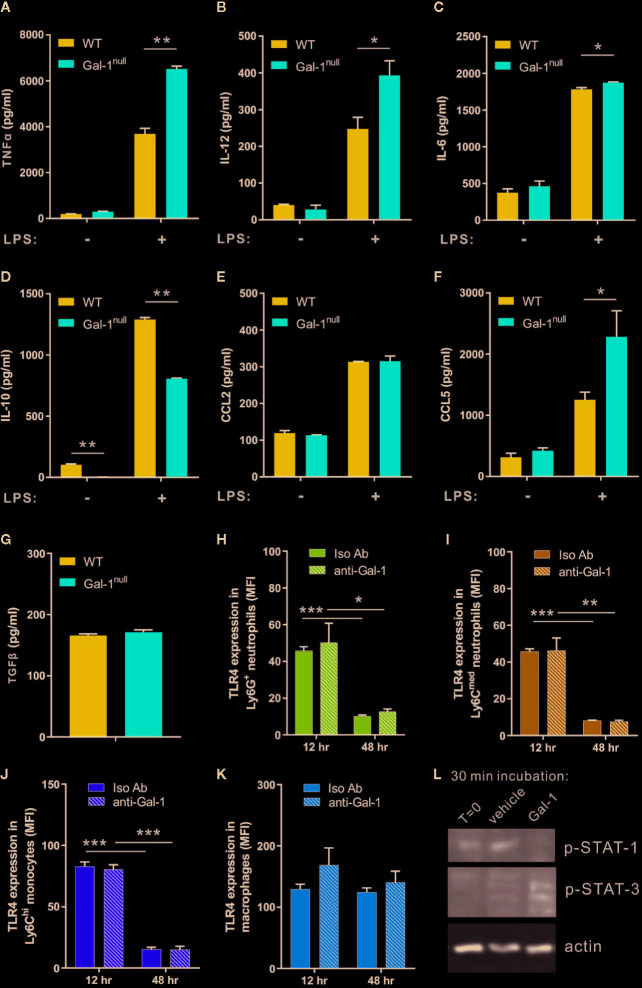
Gal-1 shifts the cytokine production of resolution-phase macrophages to promote their reprogramming. (A-G) Peritoneal macrophages were isolated from WT and Gal-1null male mice 48 h PPI and then exposed to vehicle or LPS for 24 h. The concentrations of the following cytokines and chemokines were measured in the culture media by ELISA, n = 4–6: (A) TNF-α, (B) IL-12, (C) IL-6, (D) IL-10, (E) CCL2, and (F) CCL5. (G) TGF-β concentrations in the peritoneal fluids at 48 h were directly measured. (H–K) Peritoneal cells were collected from mice treated with anti-Gal-1 or Iso Ab immunostained as in
Figure 2
, as well as for TLR4, and analyzed by flow cytometry. Then, TLR4 expression on various leukocyte subsets at 12 and 48 h was determined. (L) Macrophages were isolated from peritoneal exudates of four mice at 48 h PPI and treated with vehicle or Gal-1 (4 μg/ml) for 30 min. Then, macrophages were lysed and their protein content was run by SDS-PAGE and blotted for phospho-STAT1, phospho-STAT3, and actin. Representative images are shown. Full blot images are shown in
Figure S8
. Altogether, the data represent at least two independent experiments and are presented as mean ± SEM. Statistical significance relative to WT mice was analyzed by two-tailed Student's t-test; *p < 0.05, **p < 0.01, ***p < 0.001.